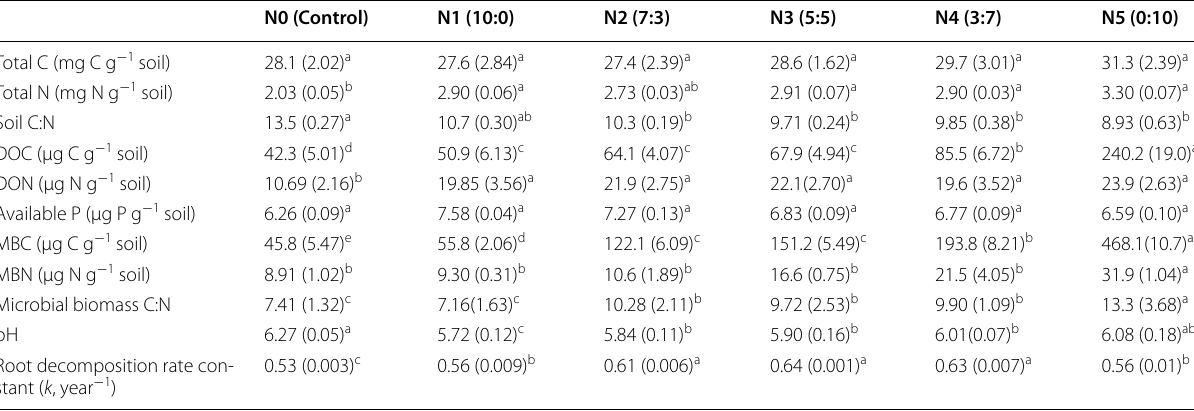
Table 1 Soil characteristics and root decomposition rate constant (single exponential) under different forms of N fertilization and control